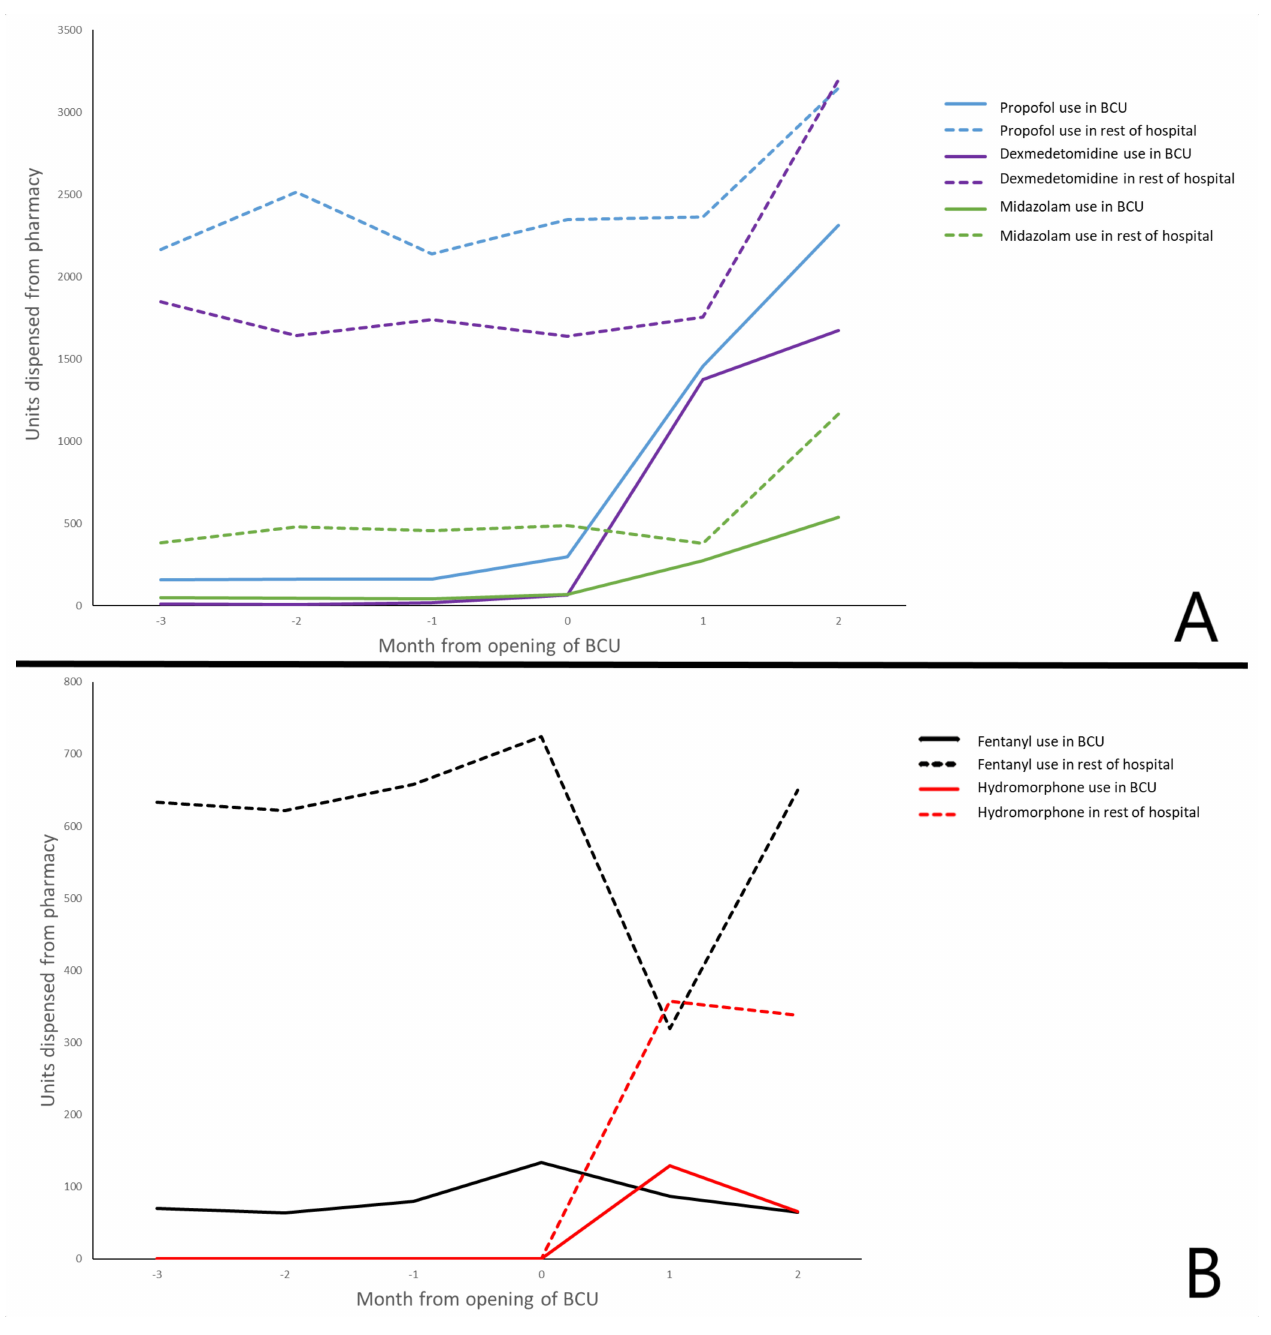
Figure 4. ( A ) Sedative use. ( B ) Narcotic use as sedation Legend: BCU—biocontainment